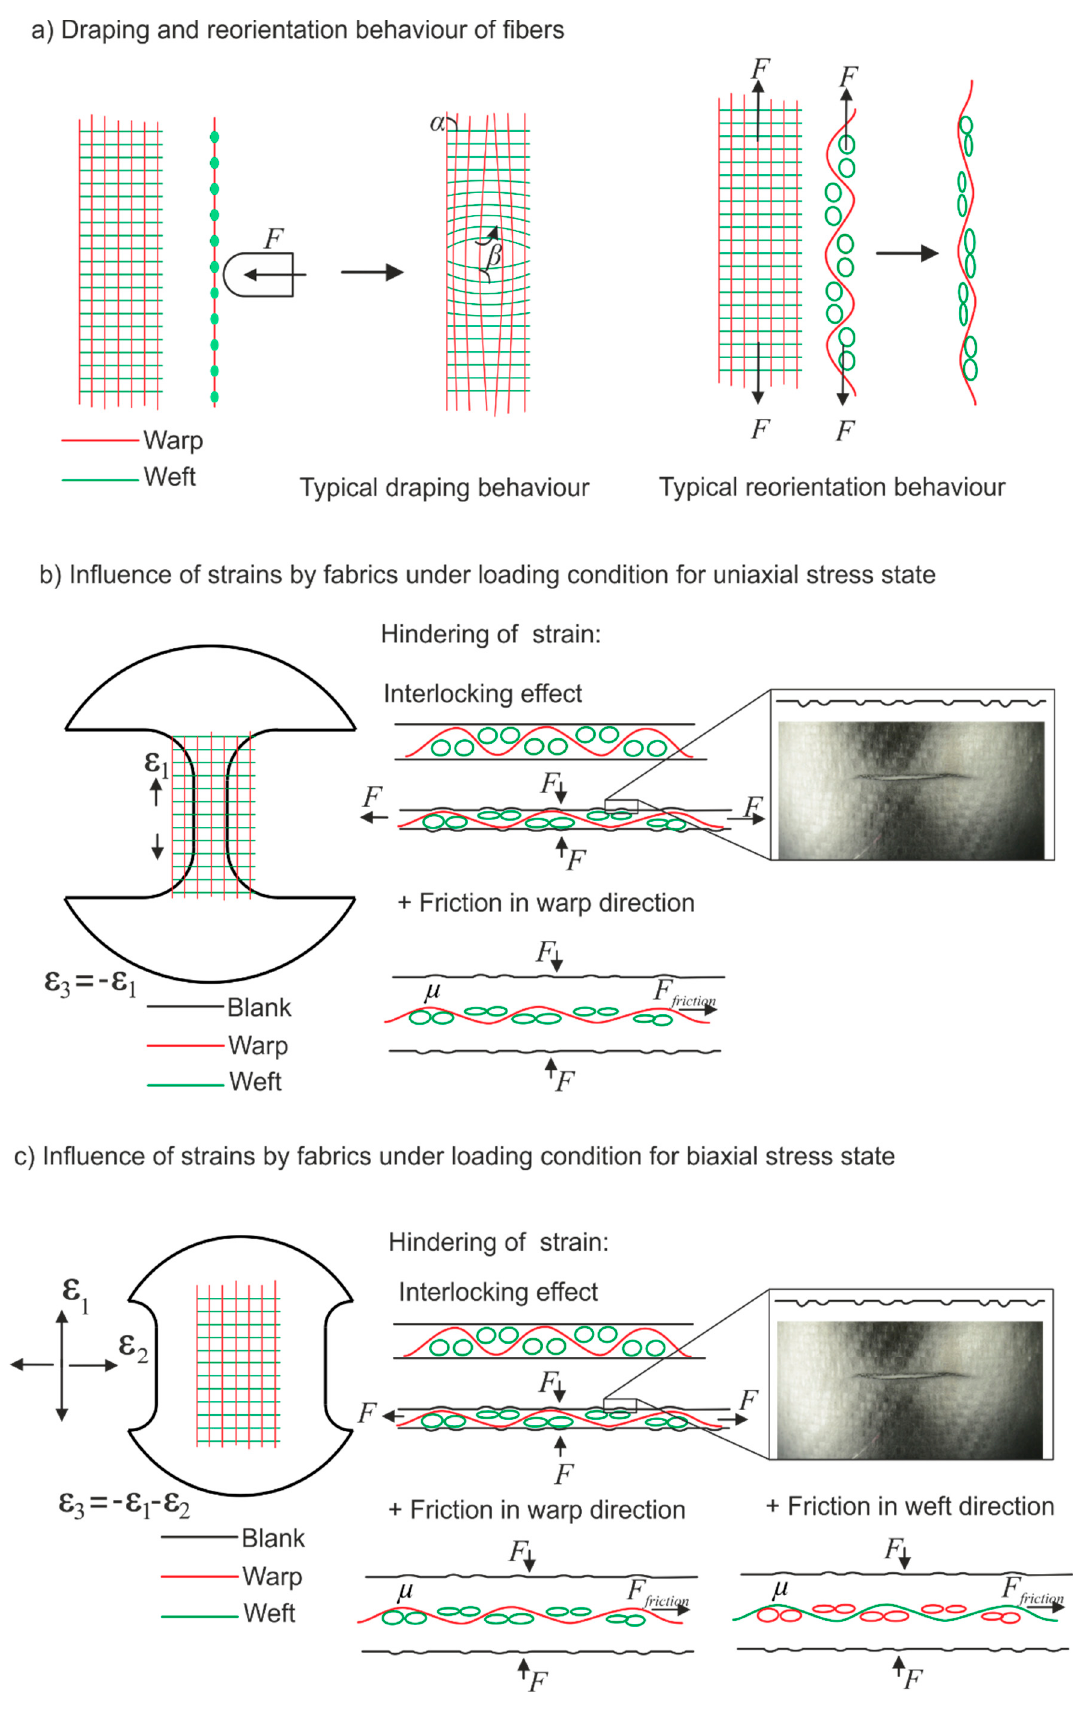
Figure 7. ( a ) Draping and reorientation behavior of fibers; ( b ) influence of fibers under normal load in uniaxial stress state; ( c ) influence of fibers under normal load in biaxial stress state.